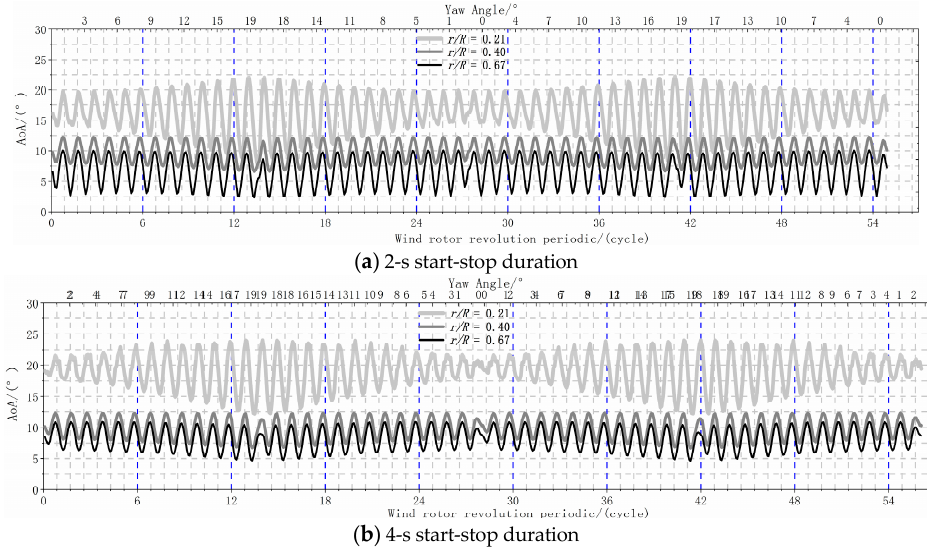
Figure 26. Comparison of AOA under different start-stop durations for three different spanwise sections under dynamic yawing.